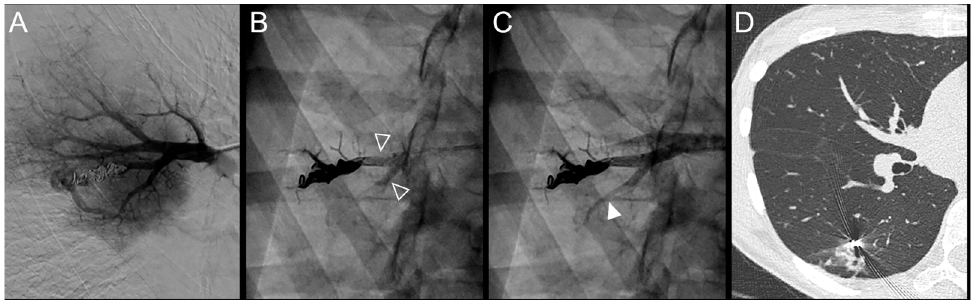
Figure 5. Case example of a 37-year-old woman treated for a simple recurrent pulmonary arterio- venous malformation in the lower right lobe. Embolization was performed using Onyx ® (0.5 mL) to